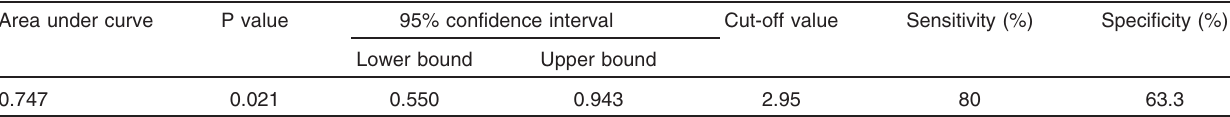
Table 9 Predictive value of diaphragmatic excursion for Global Initiative for Chronic Obstructive Lung Disease classification into high-risk and low-risk patients Area under curve